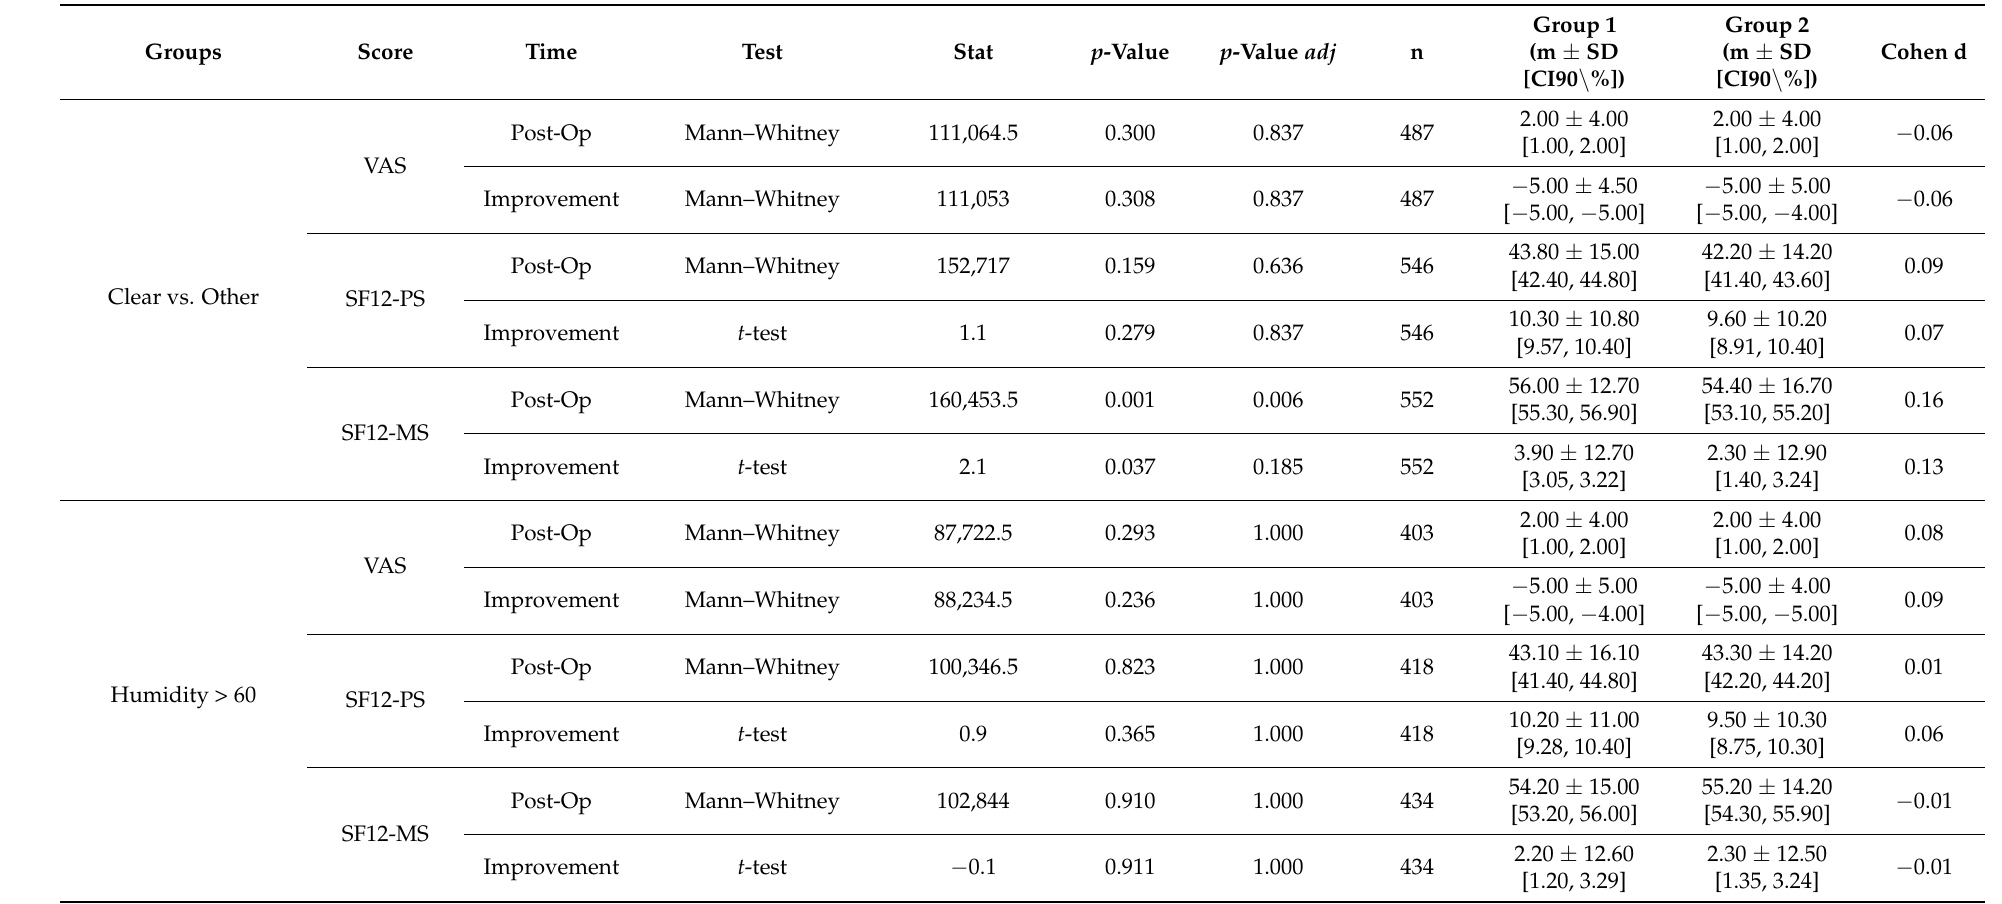
Table 4. Full results for the hypothesis tests (3-month